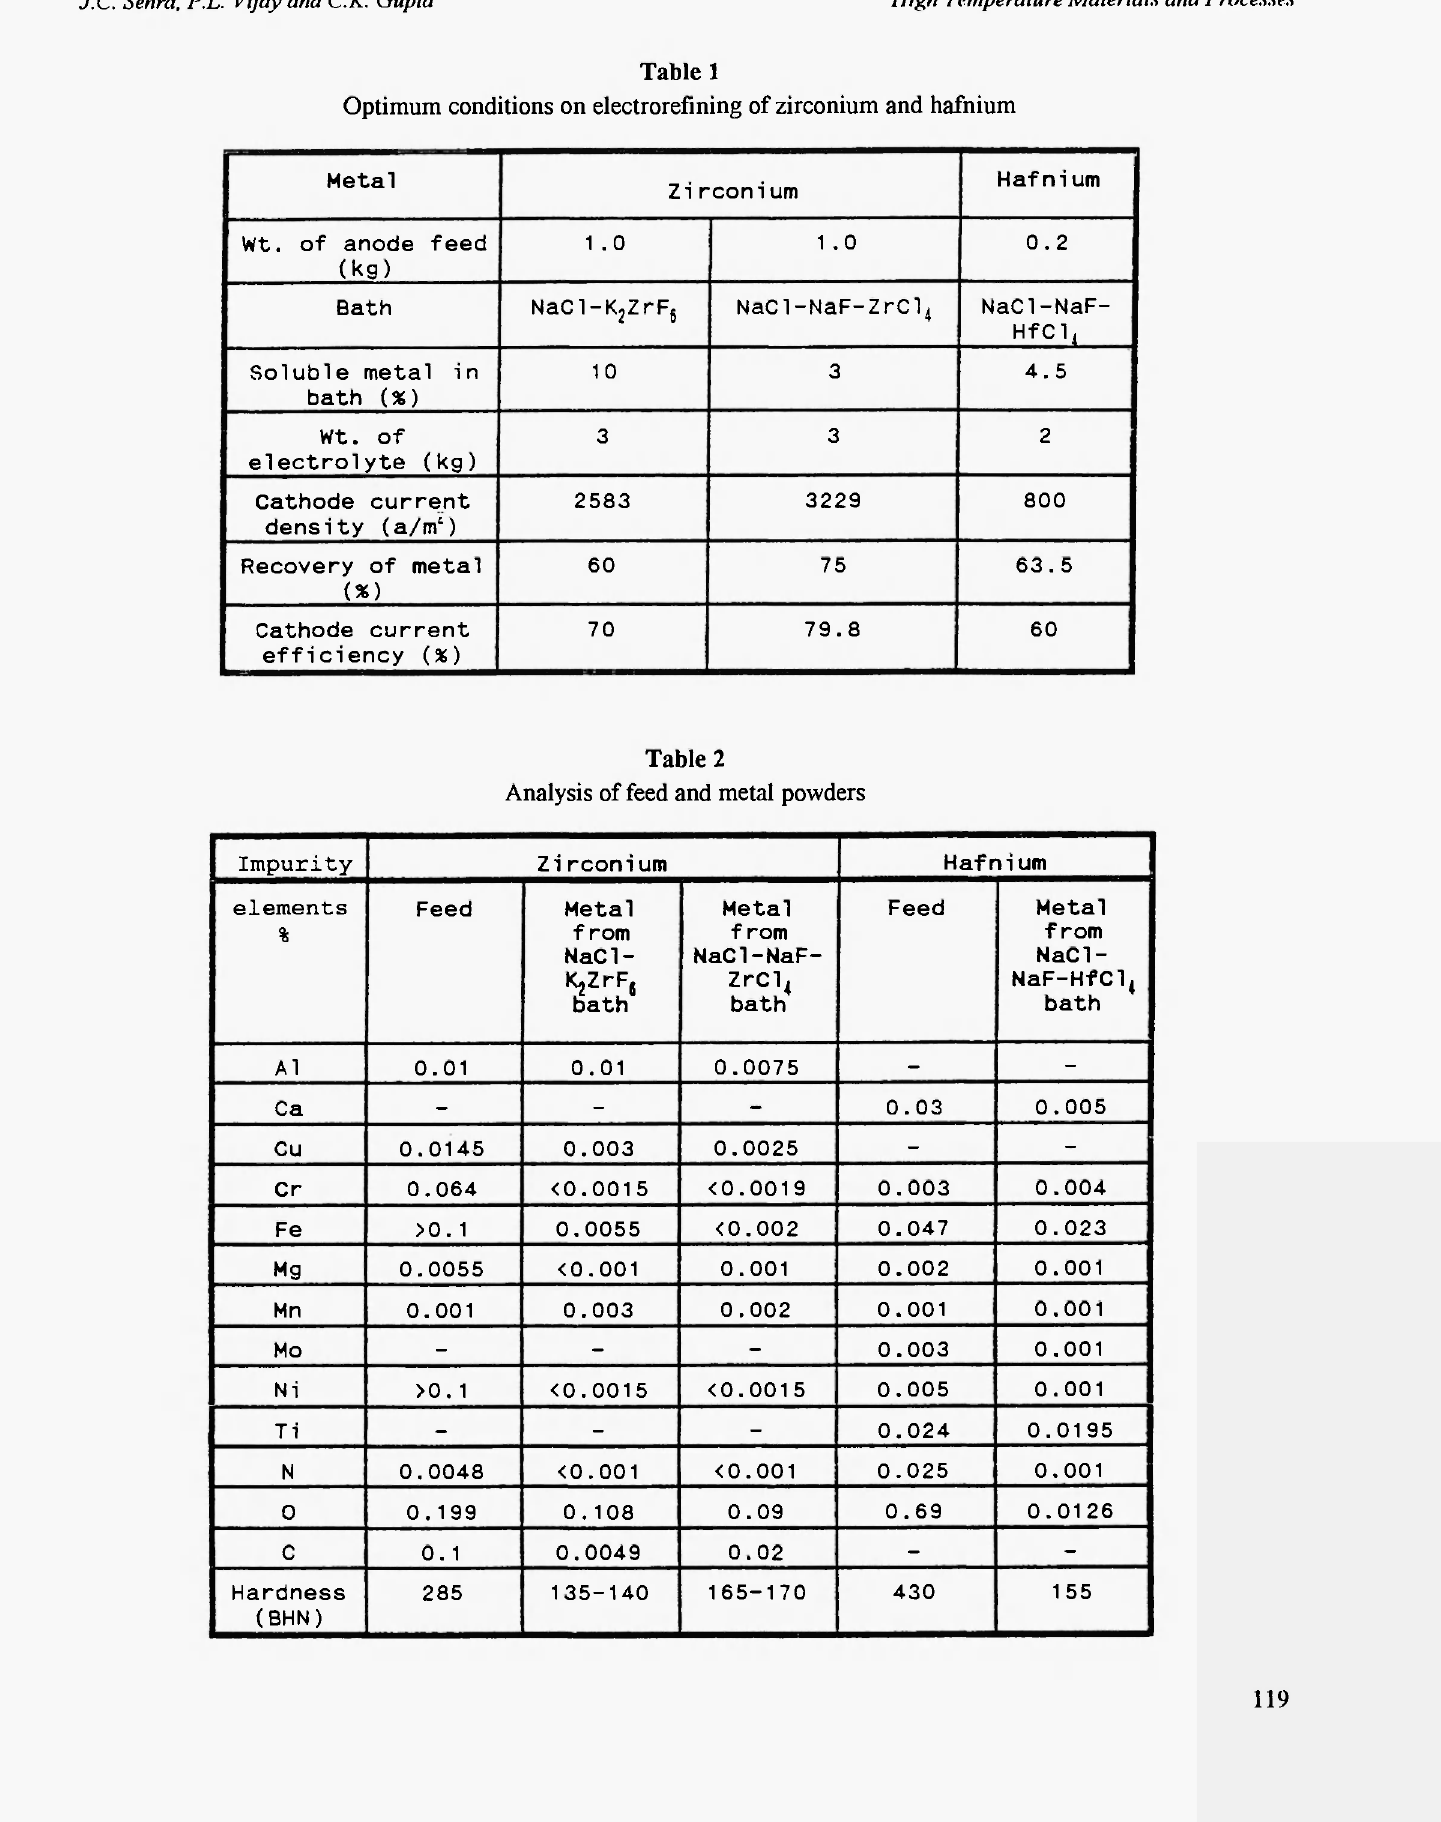
Analysis of feed and metal